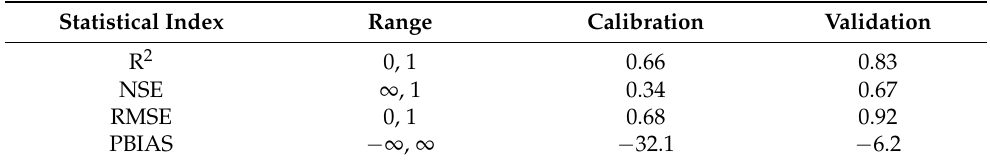
Table A2. Statistical results of the model’s effectiveness premised on the model’s validation and calibration.